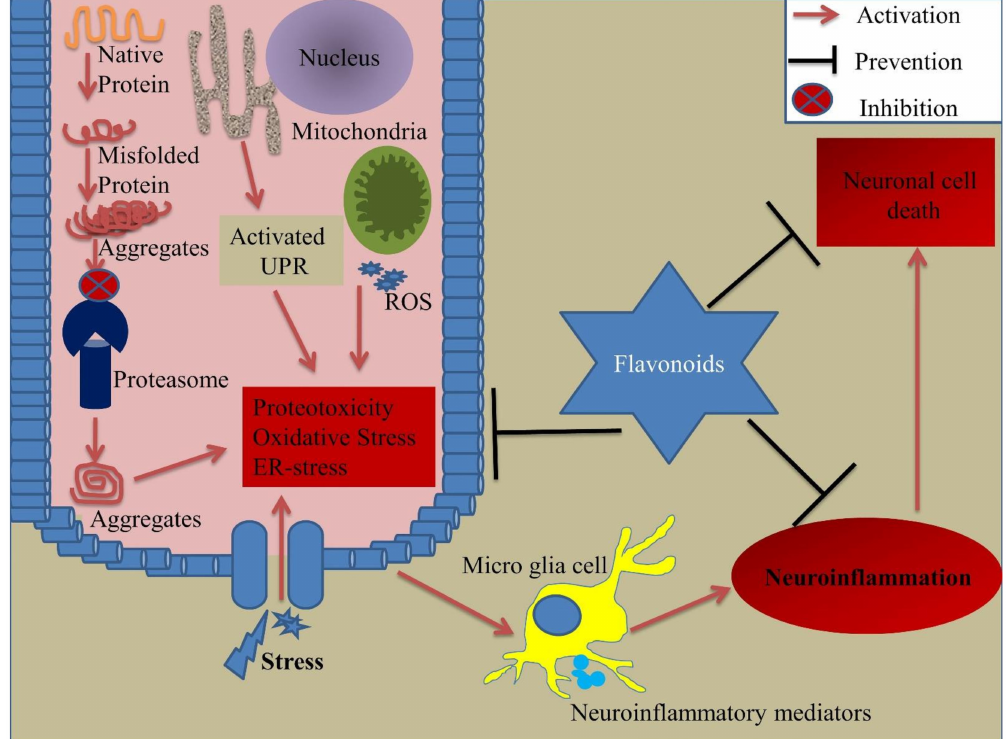
Figure 1. Role of flavonoids in prevention against cellular stress response. Exposure to stress conditions leads to the activation of cellular stress responses, such as UPR, ER stress, oxidative stress, proteotoxicity, and neuroinflammation. When cells are exposed to any stress condition, it affects the cellular proteome, thus inducing the UPR in the ER and further activation of ER stress. Stress conditions also initiate proteotoxicity by affecting the proteins’ structure, as well as proteasome subunits of the proteasomal degradation machinery, causing the release of misfolded/aggregated proteins in the cytosol, thus inducing proteotoxicity. The release of ROS from mitochondria leads to the generation of oxidative stress. All these cellular stress responses try to eliminate the stress-induced toxicity, but extreme cellular stress responses may lead to cell death. During stress exposure, microglia start to release neuroinflammatory mediators thus causing neuroinflammation. This inflammation creates a hostile environment within the cell and under harsh conditions, leads to cell death. Flavonoids have the potential to combat and prevent these exaggerated cellular stress responses in-turn preventing cell death. ER: Endoplasmic reticulum, ROS: Reactive oxygen species, UPR: Unfolded protein